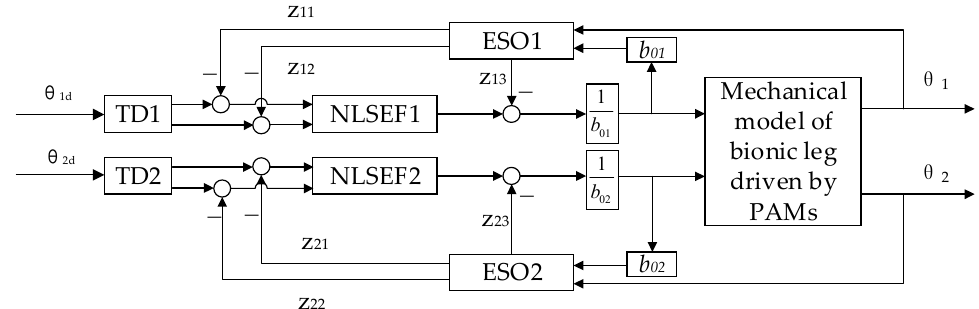
Figure 5. Schematic diagram of the position control of the bionic leg with ADRC.